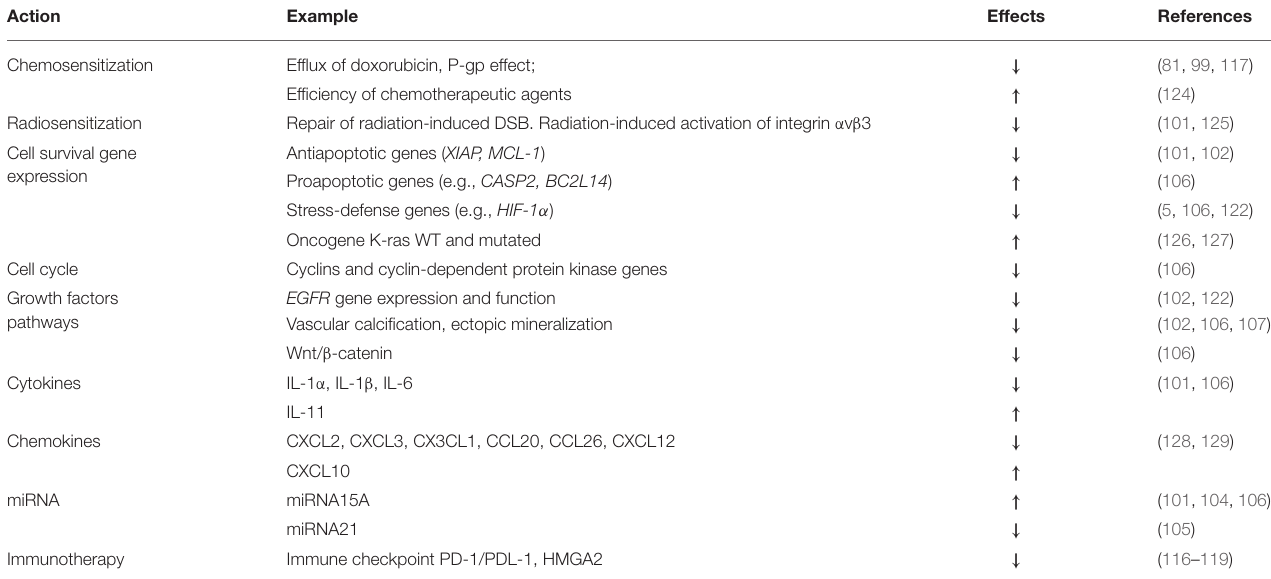
TABLE 1 | Mechanisms of reported and possible chemotherapeutic actions of tetrac/Nanotetrac/Nano-diamino-tetrac.